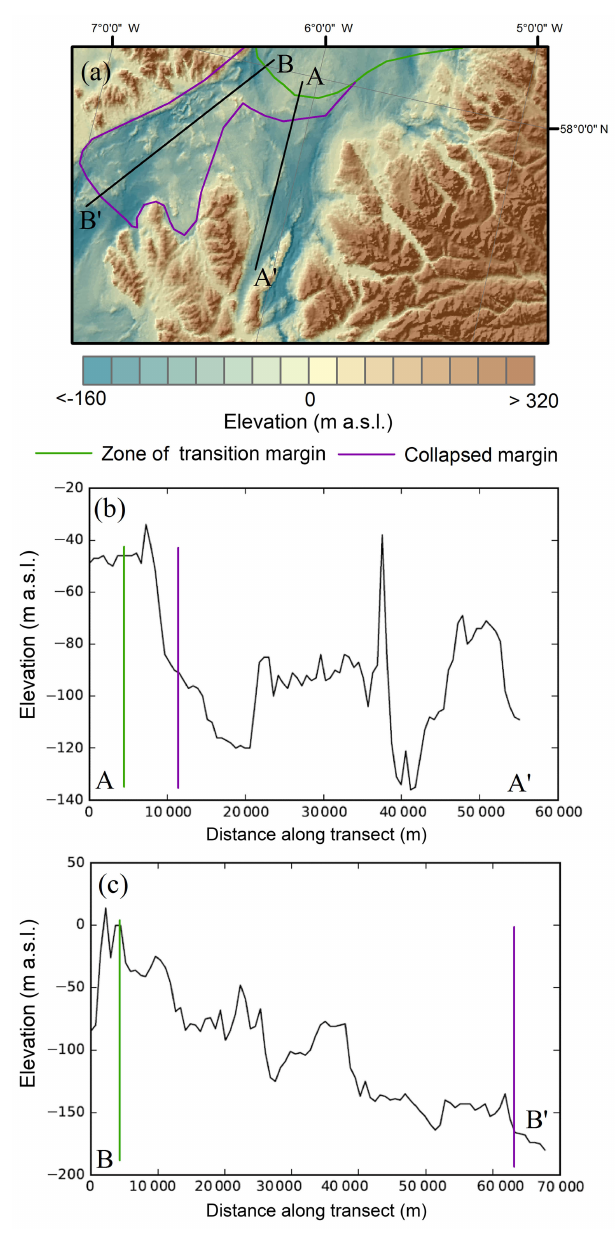
Figure 8. The difference in the effects of MISI between the east trough and the west trough. (a) The 6400-model-year RETREAT margin (green) and the stable “collapsed” extent margin (purple). (b) A-A (cid:48) transect of bathymetry and collapse extent in the east trough. (c) B-B (cid:48) transect of bathymetry and collapse extent in the west